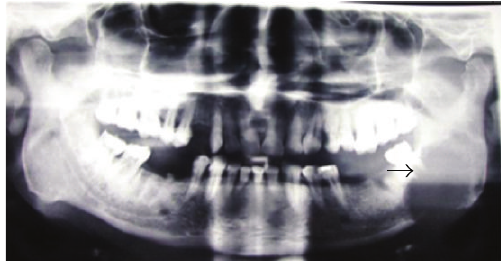
Figure 2: OPG showing osteolytic lesion involving left angle and ramus of mandible.